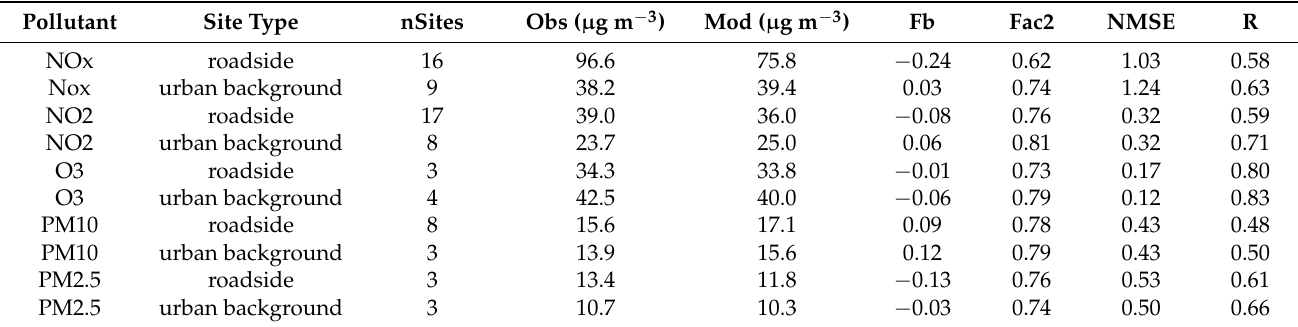
Table 2. Statistics for model evaluation for the baseline year of 2016 calculated from the hourly modelled and measured concentrations. nSites: number of sites; Obs: observed concentration; Mod: modelled concentration; Fb: fraction bias (ideal value is 0); Fac2: fraction of modelled data within a factor of 2 of observations (ideal value is 1.0); NMSE: normalised mean square error (ideal value is 0); R: correlation coefficient (ideal value is 1.0).